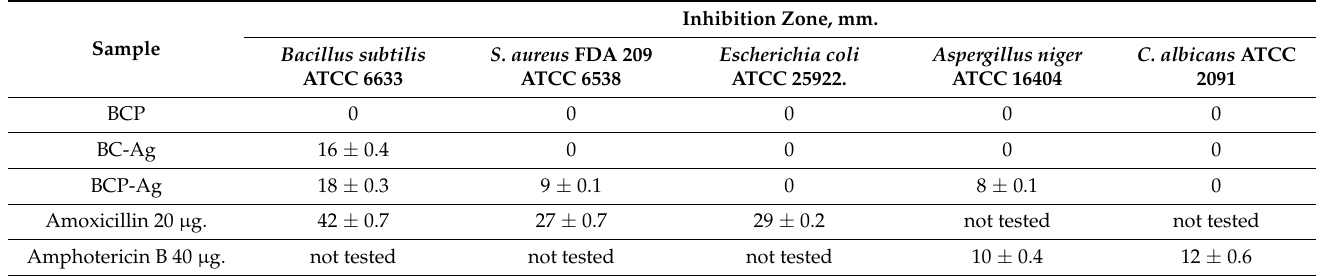
Amphotericin B 40 µ